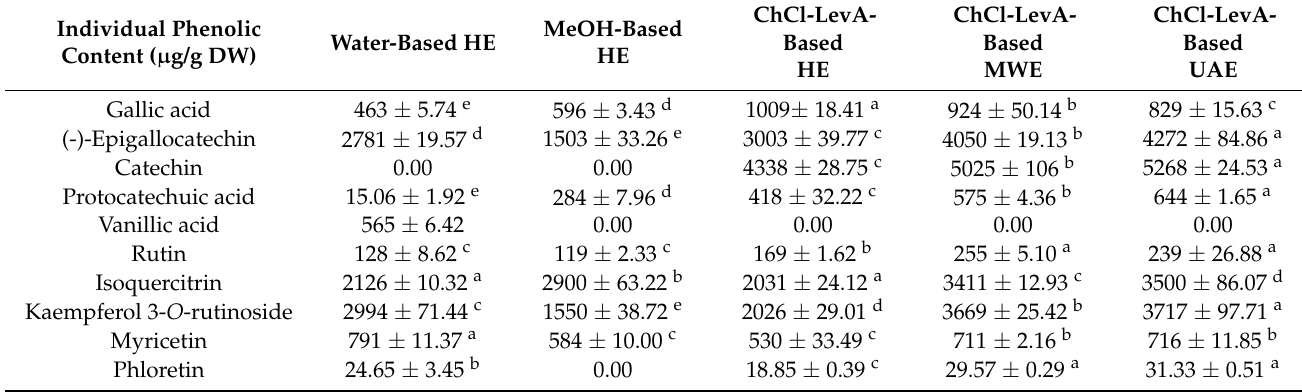
Table 4. Individual phenolic contents in the DLT extracts obtained by different extraction